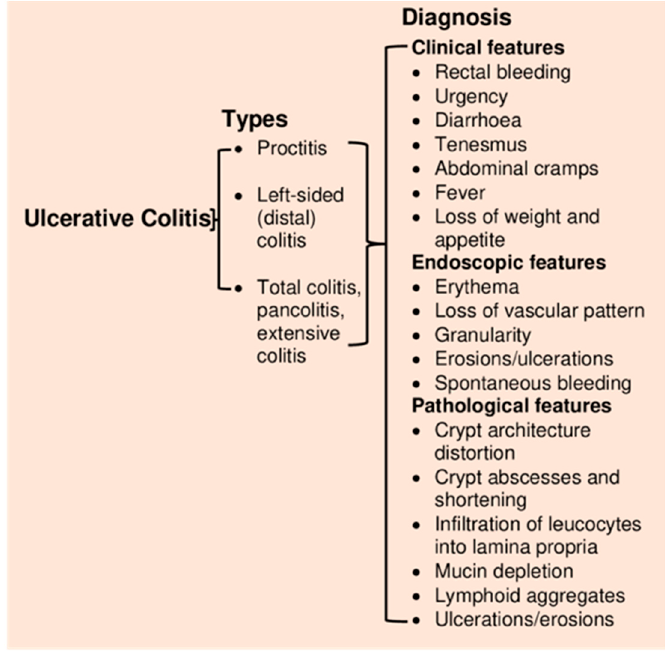
Figure 2. Types of ulcerative colitis and diagnosis.